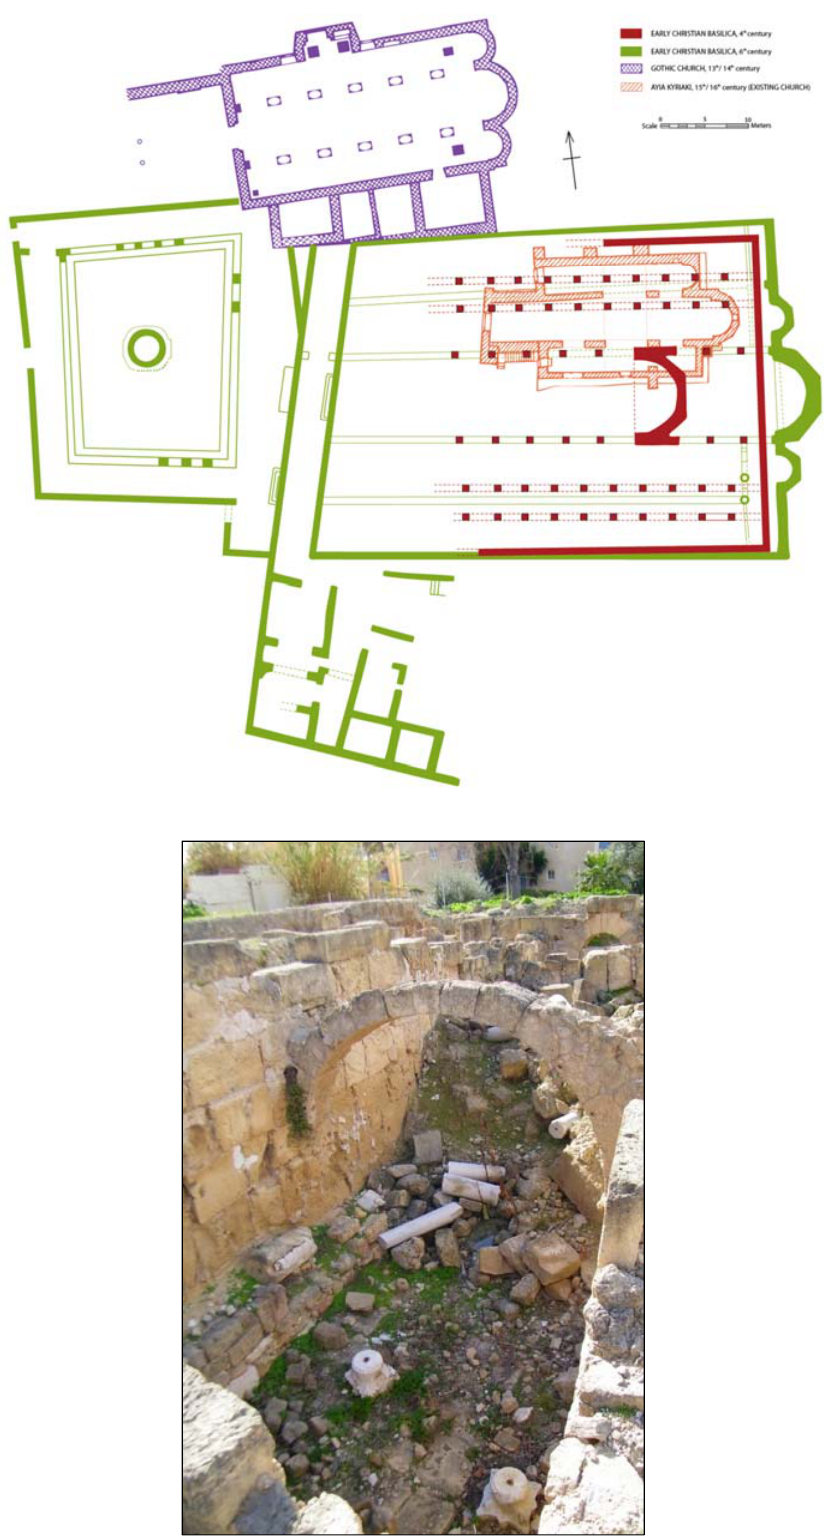
Figure 3. Plan of Panagia Chrysopolitissa and view south of the residence (Plan courtesy of the Department of Antiquities Cyprus, Photo: C. Keane).